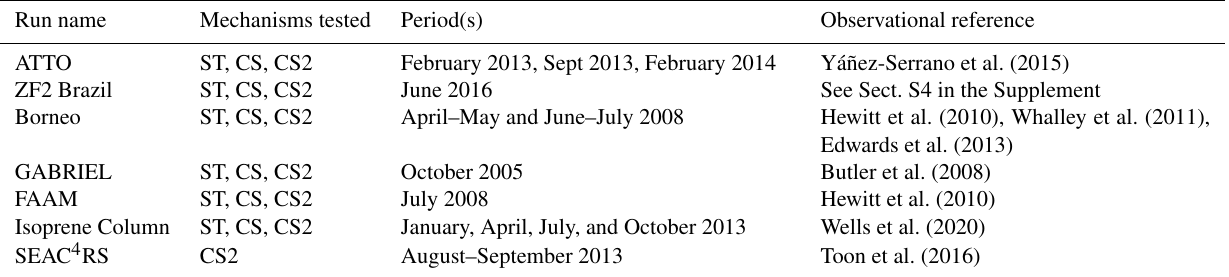
Table 3. Shorter runs performed for mechanism–observation comparisons. Identical biogenic (2001–2010 MEGAN-MACC climatology; iBVOC for isoprene and MT) and ocean (1990 time slice) emissions for each run unless otherwise stated.